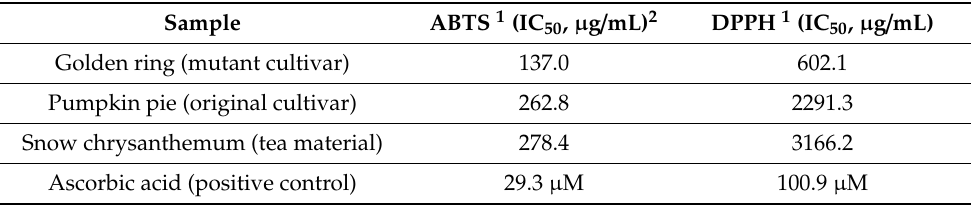
Table 3. Antioxidant activities of the dichloromethane extract of three di ff erent Coreopsis cultivars.